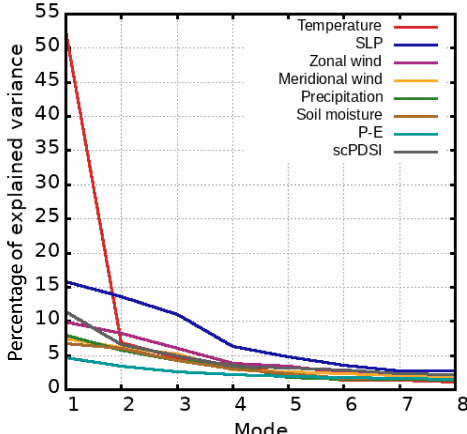
Figure 3. Percentage of variance explained by the first eight modes obtained with the multi-model EOF analysis of temperature, SLP, zonal and meridional wind, precipitation, soil moisture, P – E , and